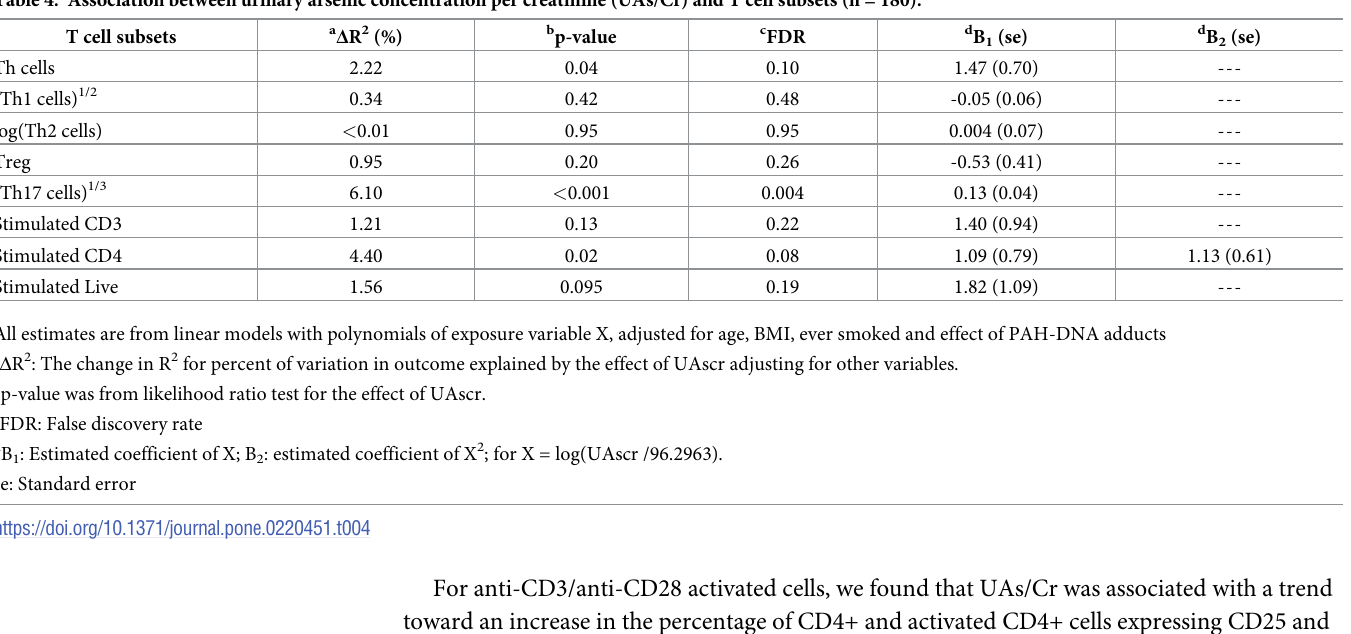
For anti-CD3/anti-CD28 activated cells, we found that UAs/Cr was associated with a trend toward an increase in the percentage of CD4+ and activated CD4+ cells expressing CD25 and CD69. There was a moderate statistical association with As exposure and an increase in the percentage of Th17 cells. In contrast, PAH-DNA adducts associated with Th17 cells non- monotonically with a trend towards a decrease. At high levels of PAH-DNA adducts, we